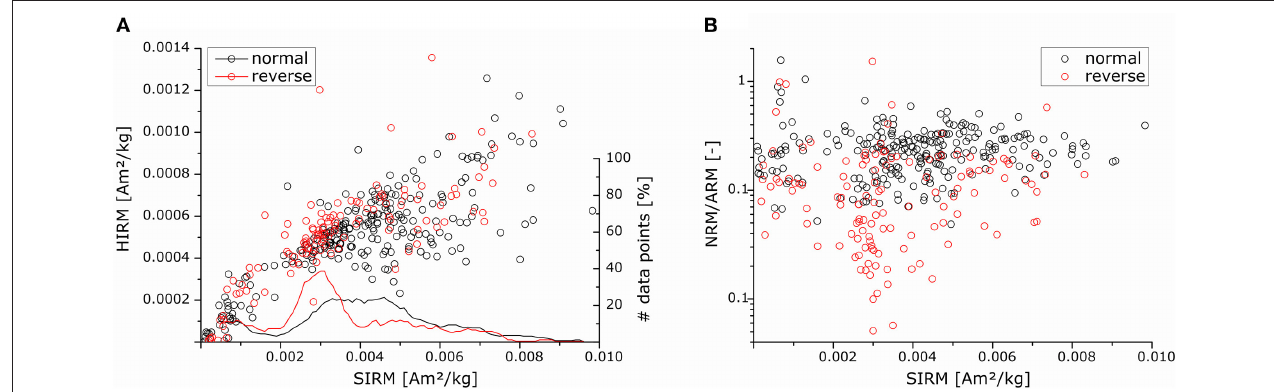
FIGURE 11 | (A) HIRM vs. SIRM and (B) NRM/ARM vs. SIRM scatter plots. In black (red) are the data points for samples with normal (reverse) polarity directions. The solid curves in A indicate the relative distribution of data points calculated from running means of 0.001 Am ² /kg-windows for samples with normal (black) and reverse (red) polarity